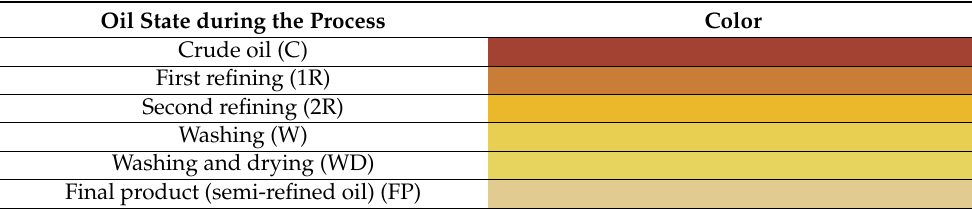
Table 18. Semi-refined cotton oil process with its color [110].